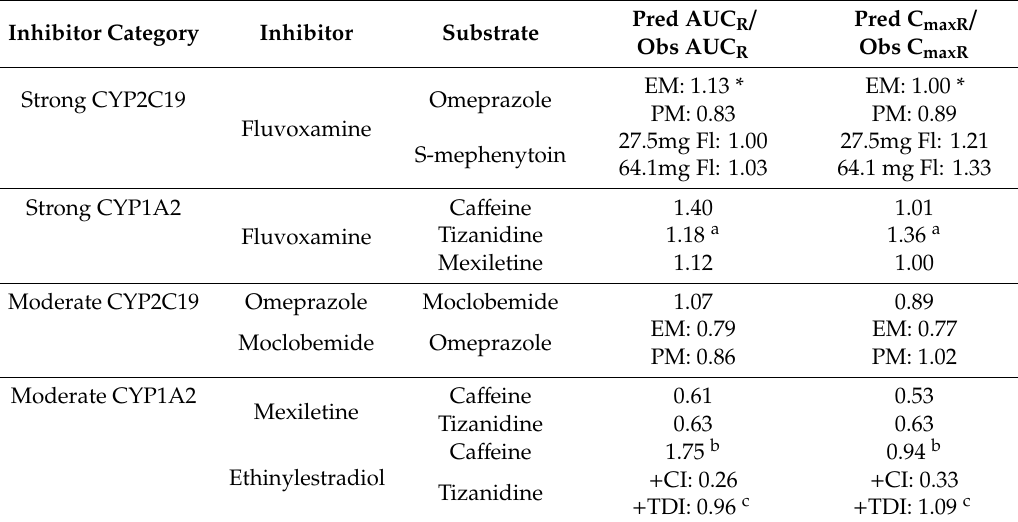
Table 3. Overview of results of DDI predictions of template